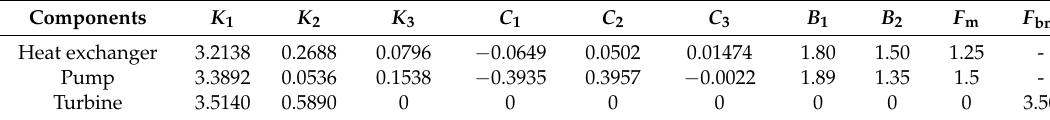
Table 1. Coefficients required for cost evaluation of each component